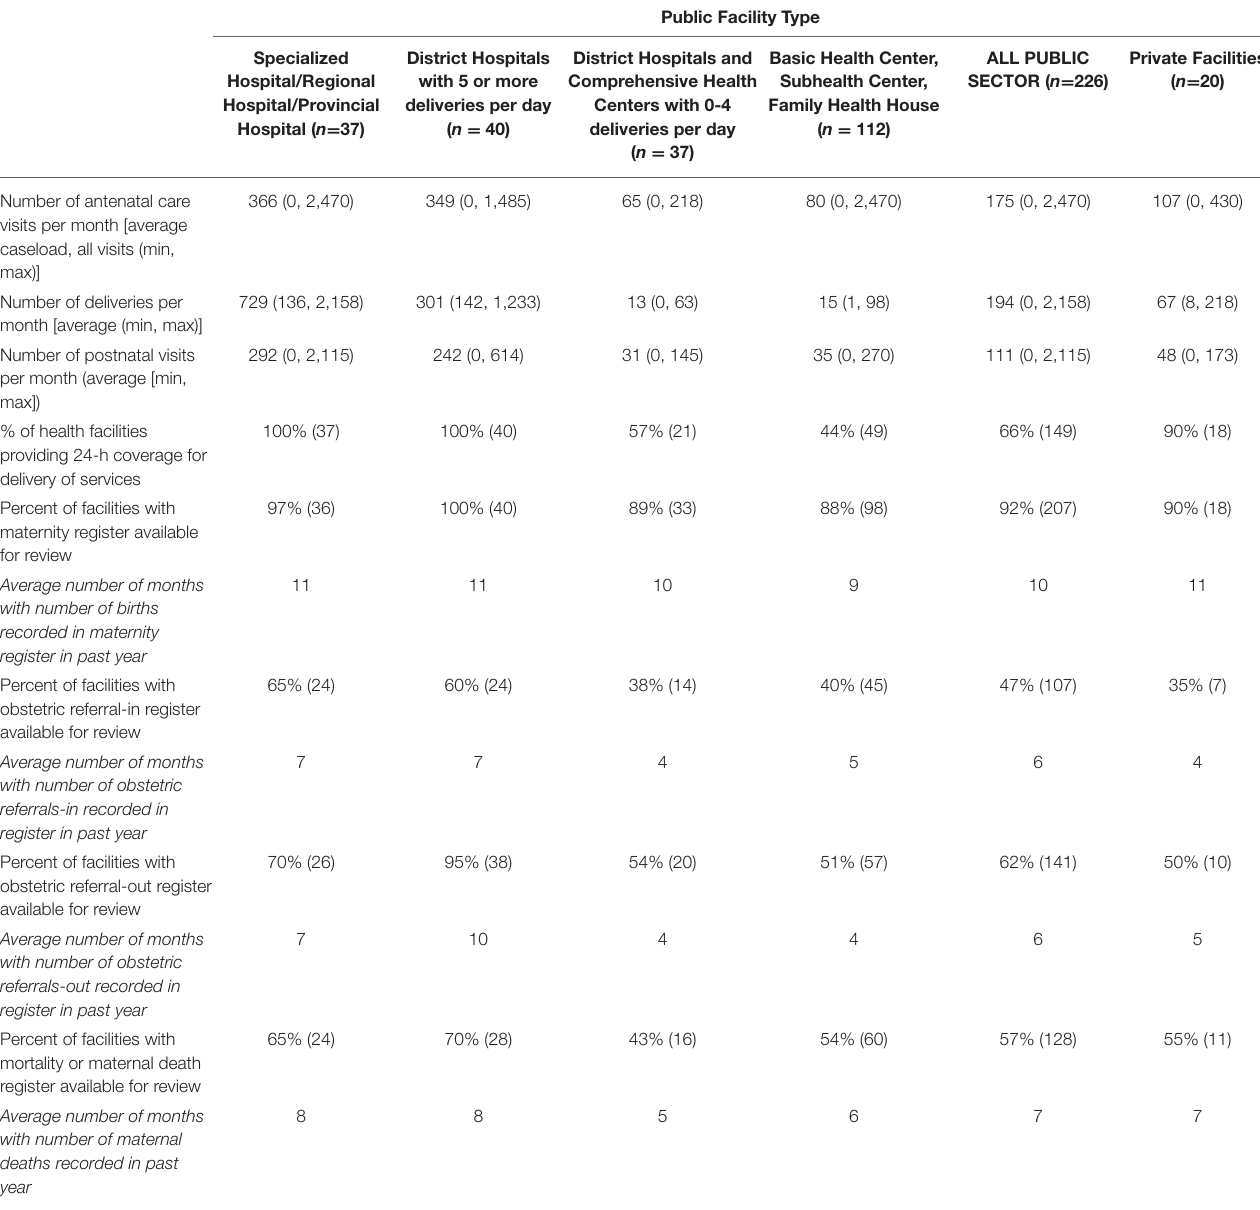
TABLE 1 | Health facility characteristics (maternity caseload and data